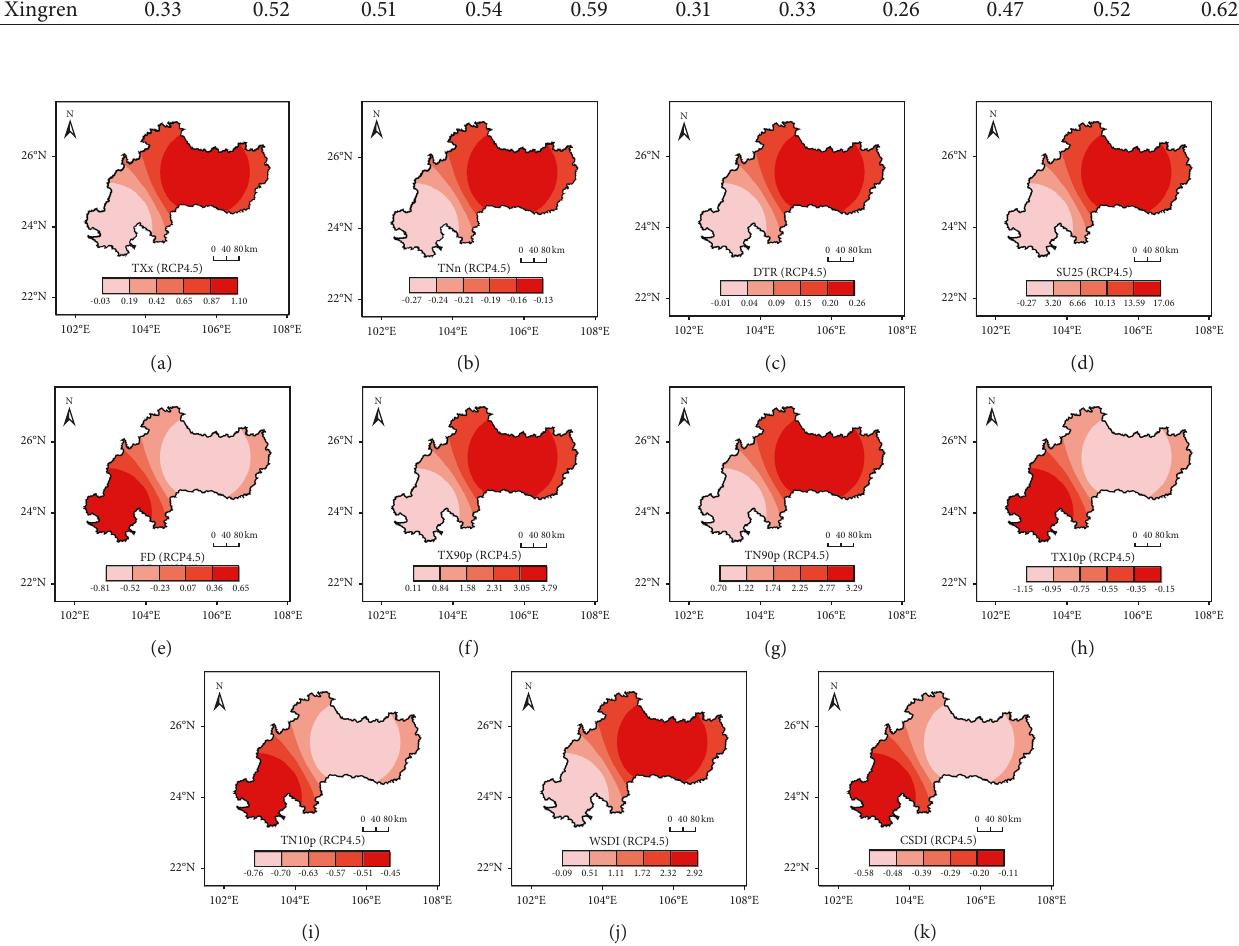
Figure 7: Spatial distribution of interdecadal variability of temperature extremes for 2021–2050 under the RCP4.5.